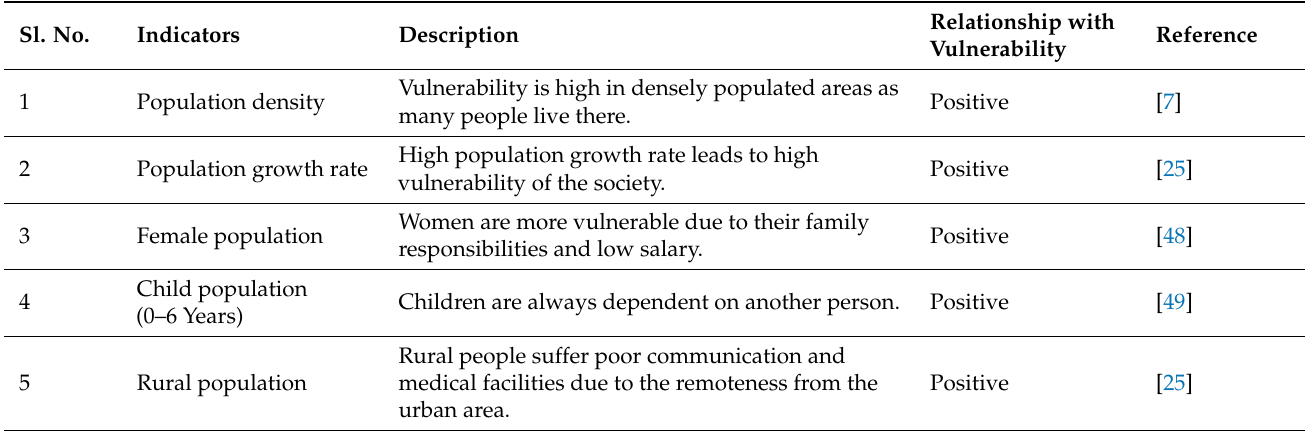
Table 2. Different indicators of vulnerability